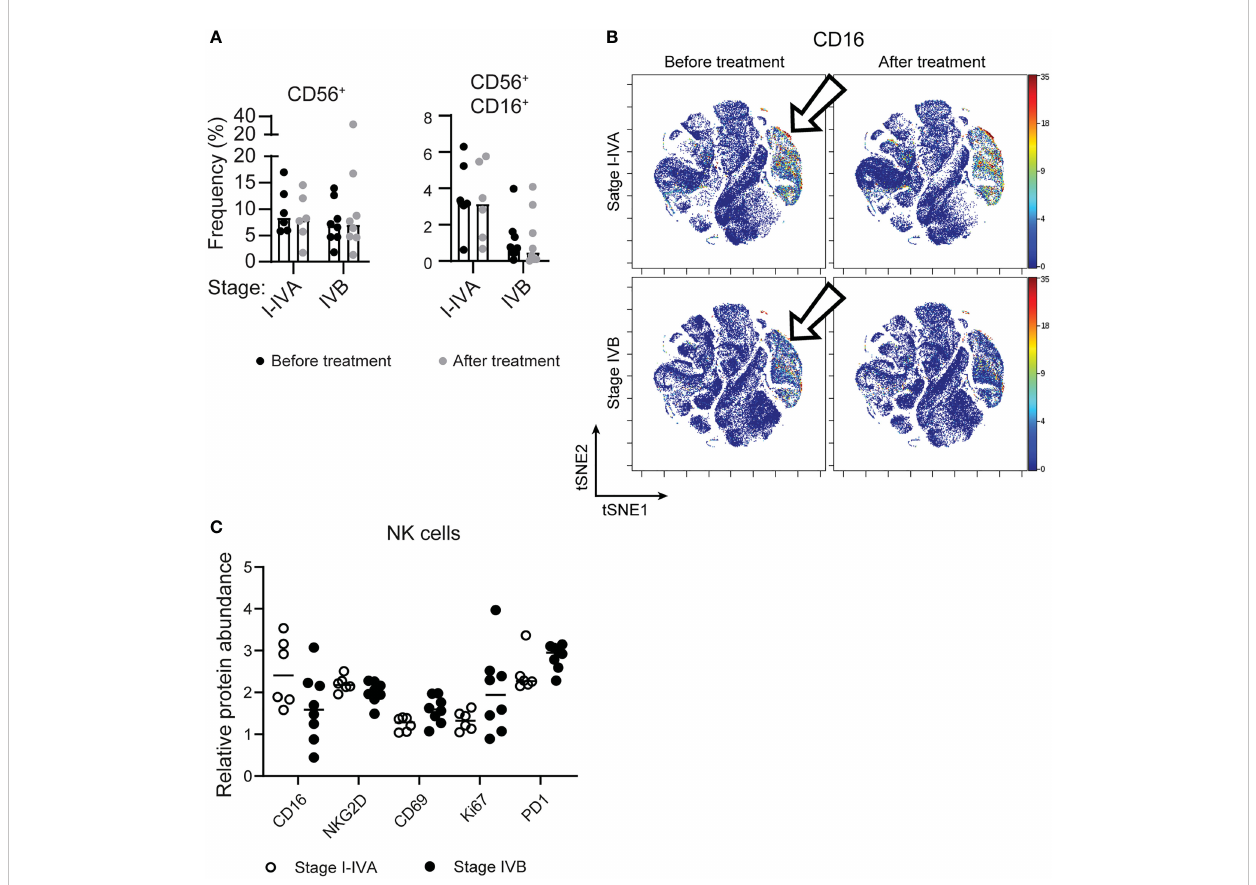
FIGURE 2 Later stage NSCLC patients have lower expression of CD16 on circulating NK cells. (A) The frequency of CD56+ NK cells and CD56+ CD16+ NK cells as a proportion of all CD45+ cells is plotted across patient groups. (B) tSNEs of concatenated NSCLC patient data, as in Figure 1, are colored according to CD16 expression, which is signi fi cantly different on the NK cell subset (arrows). (C) The relative protein abundance (Astrolabe diagnostics) is plotted on all CD56+ cells from NSCLC patients before treatment for CD16, NKG2D, CD69, Ki67 and